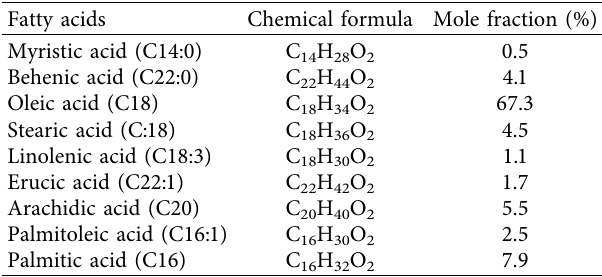
Table 5: Percentage of oil extracted from Moringa oleifera seeds. Fatty acids Chemical formula Mole fraction